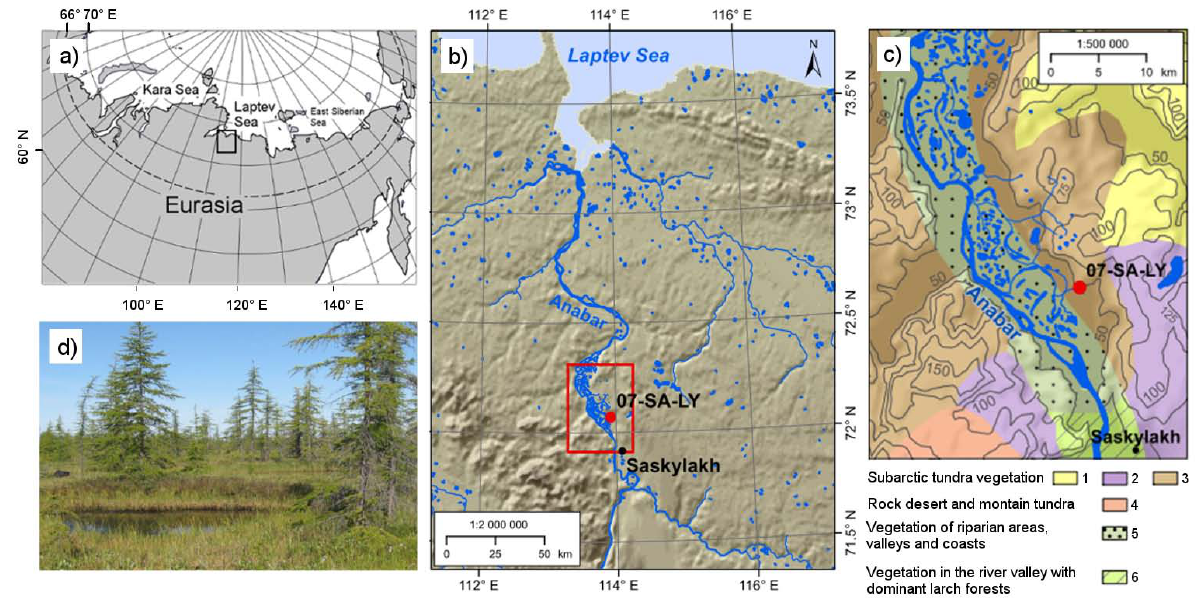
Fig. 1. Location of the study area. The studied polygon (07-SA-LY) is located south of the Taymyr Peninsula (a) and 160km south of the Laptev Sea coastline in the vicinity of the Anabar River, North Siberian Lowland (b) , within an abandoned meander on the river’s floodplain (c) . Larix is sparsely distributed throughout the area (d) and the land surface is covered with a shrub–moss community. (Photo: U. Herzschuh, August